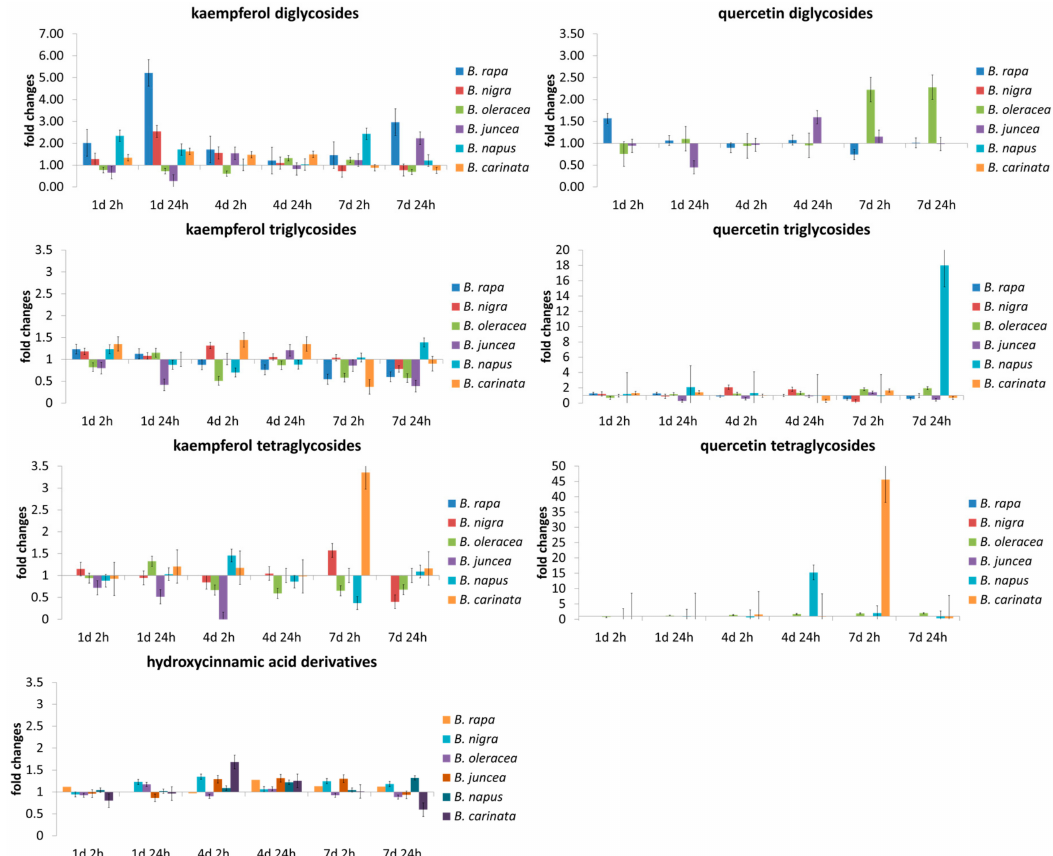
Figure 2. Relative changes in the concentration of flavonoid glycoside groups (separated on the type of aglycone and the glycosylation pattern) and hydroxycinnamic acid derivatives of related Brassica species normalized on the value of the control plants at the certain time points (at days 1, 4, and 7 of the treatment with 2 h or 24 h of adaptation time after the last UV